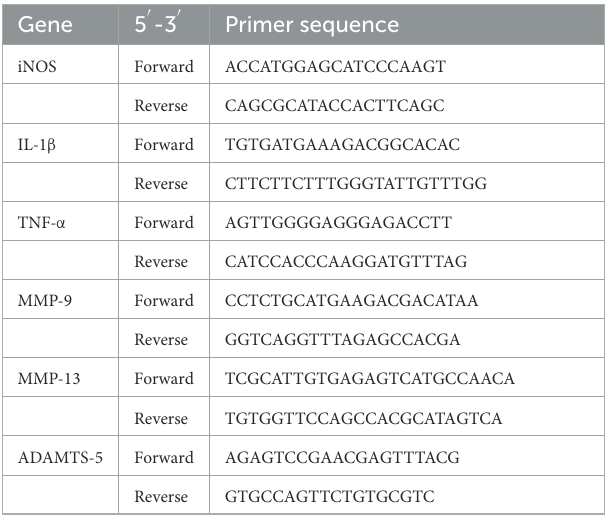
TABLE 1 Primer sequences used for real-time